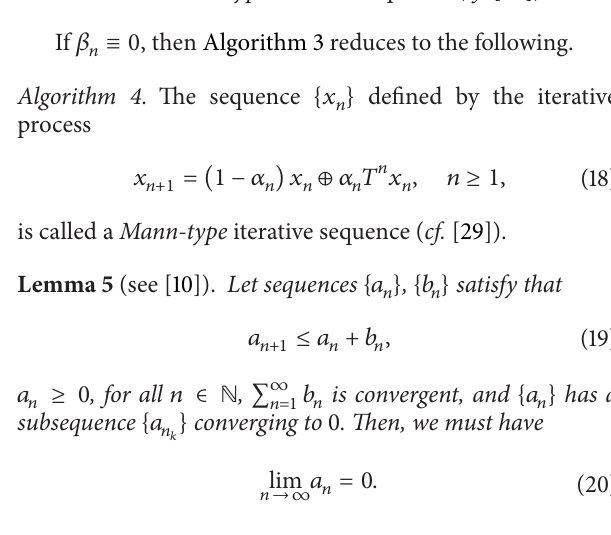
Algorithm 4. The sequence {𝑥 𝑛 } defined by the iterative